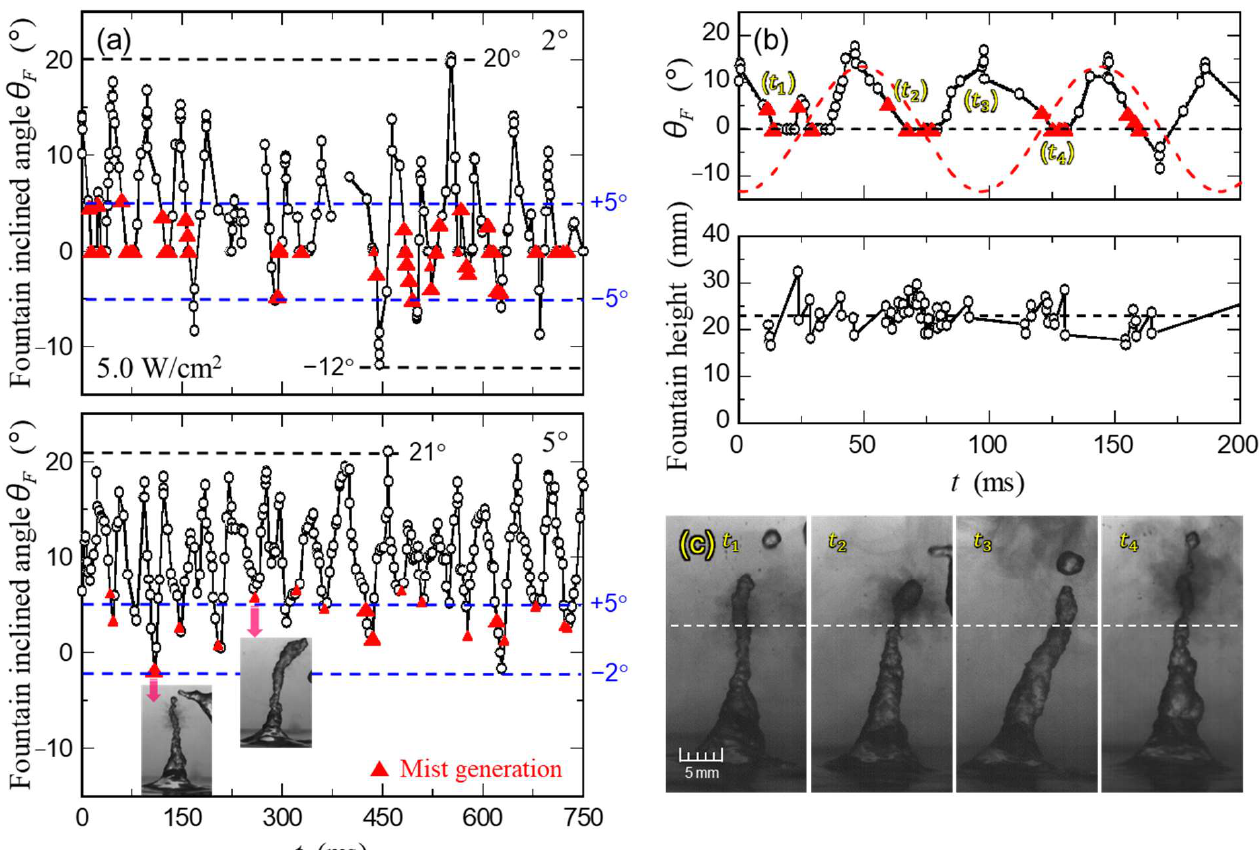
Figure 5. Time variations ( a ) in fountain inclined angle, associated with mist generation, for trans- ducer setting angles 𝜃 (cid:3021) of 2 and 5 at 5.0 W/cm 2 , and ( b ) in fountain inclined angle and height for 𝜃 = 2 over selected time interval with ( c ) some images of fountain for representative phases of oscillations.